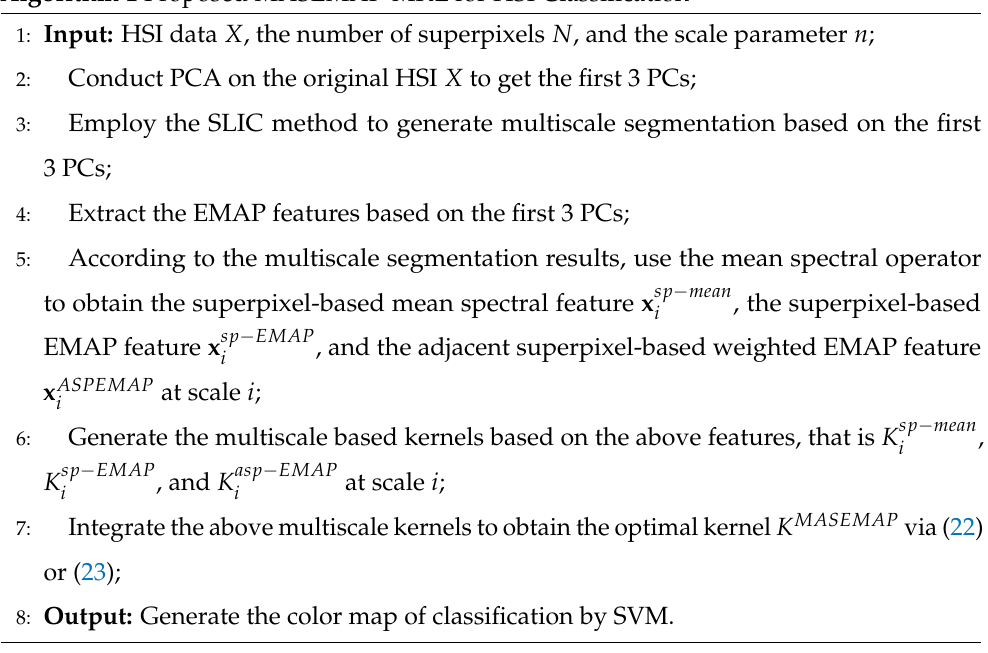
Algorithm 1 Proposed MASEMAP-MKL for HSI